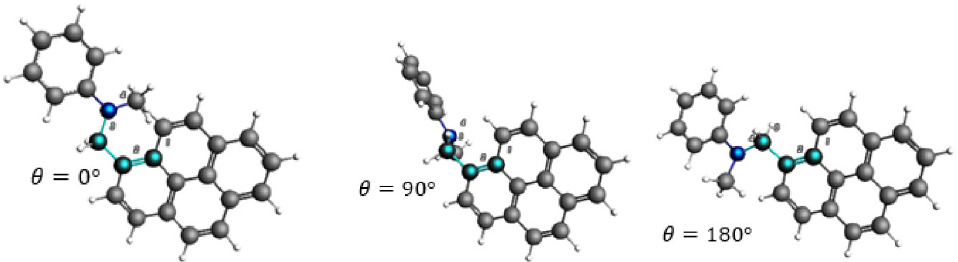
Figure 8. The dihedral angle defined between the pyrene acceptor and the dimethylaniline donor. Left : The ground state of PyrDMA at a dihedral angle of 0°. Centre: Ground state of PyrDMA at an orthogonal geometry. Right : The molecule at a dihedral angle of 180°.